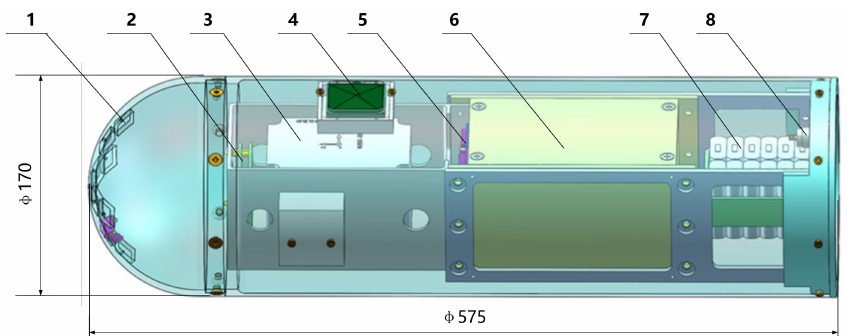
Figure 3. Internal structure of the proposed flush air data sensing module. 1-Pressure sensor unit, 2-Onboard computer, 3-Integrated navigation unit, 4-Satellite antenna, 5-Electrical interface, 6-Data recorder, 7-Battery pack, 8-System